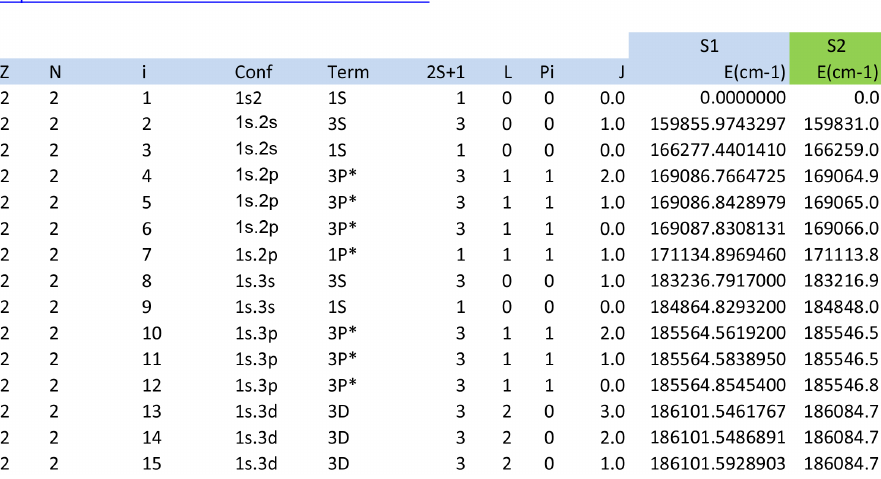
Figure 5. Workbook 02_02 for He I showing the 02_02.E0 worksheet with a 49-level atomic model (only the first 15 levels are